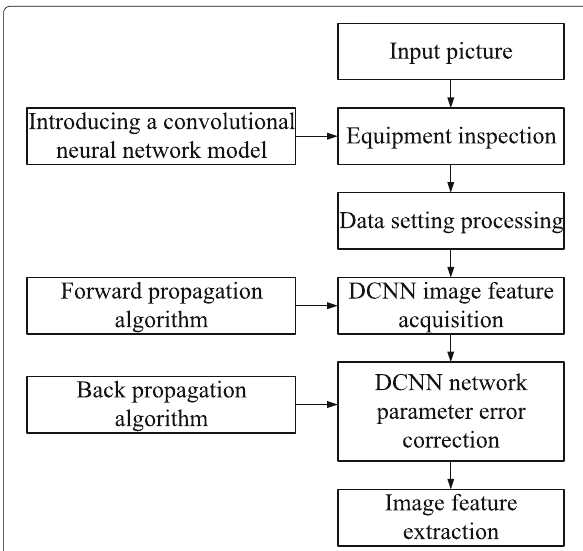
Fig. 3 Flow chart of electric equipment characteristics